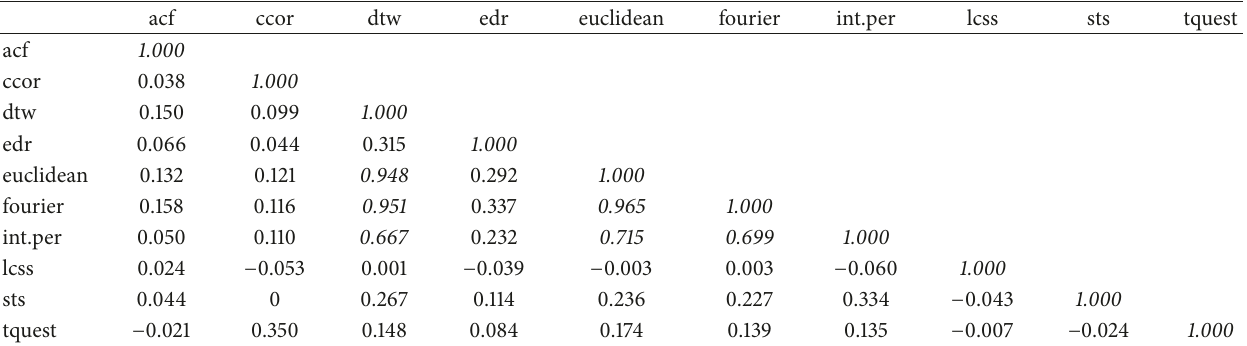
Table 3: Baker’s correlation coefficient between clustering results on the basis of different measures of time series